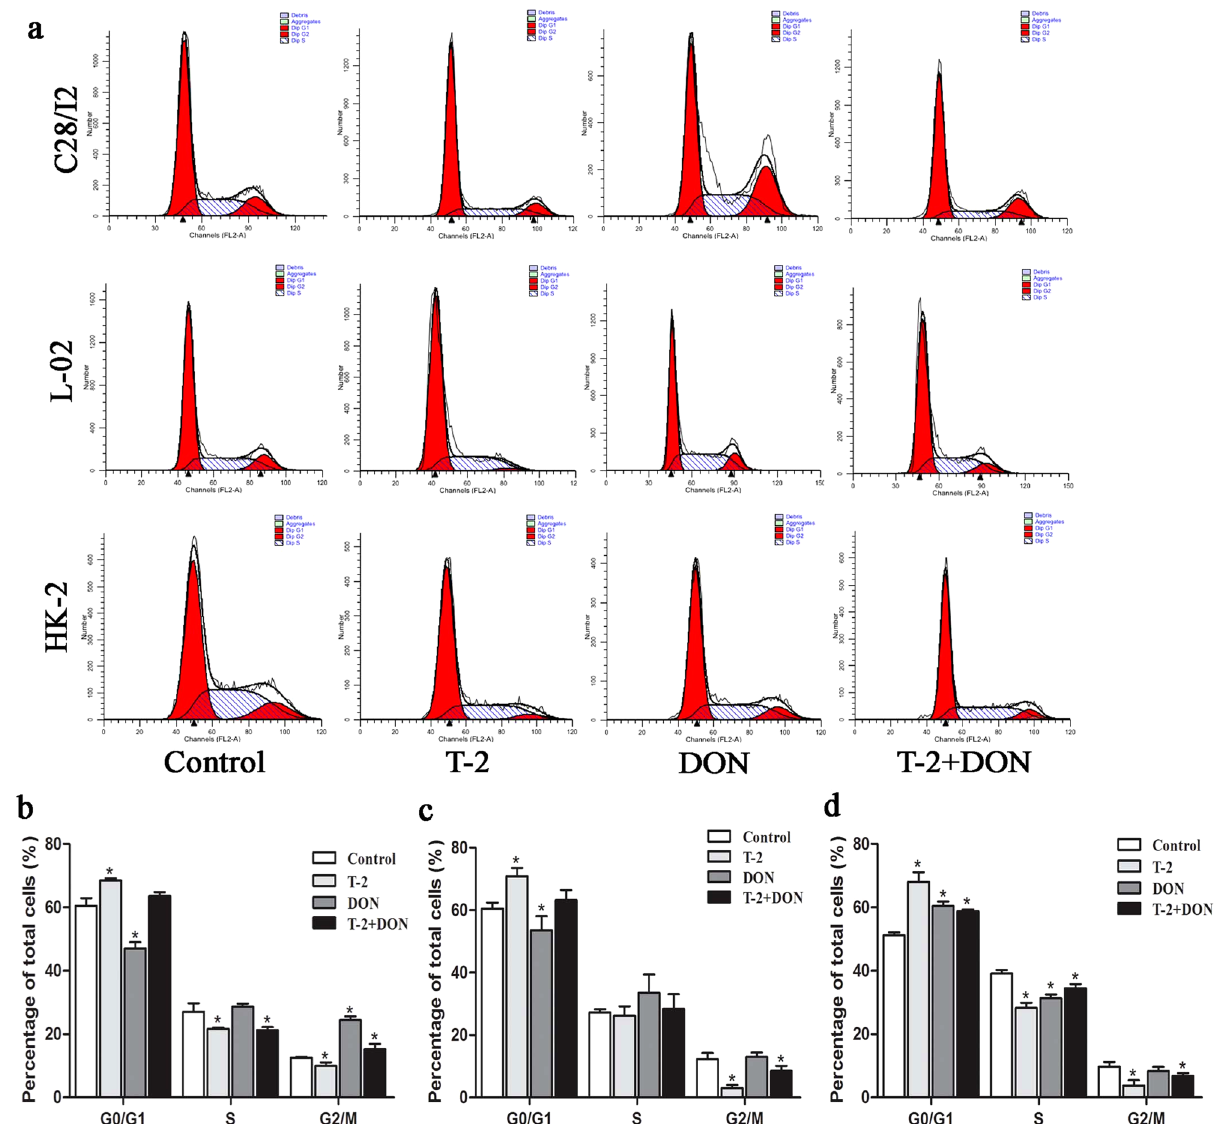
Figure 5. Cell cycle arrest induced by T-2 toxin and/or DON. ( a ) C28/I2, L-02, and HK-2 cells were exposed to T-2 toxin (10 ng/ml) or DON (800 ng/ml), alone or in combination, for 24 h. and cell cycle phase distribution was analyzed by flow cytometry. Cell cycle phase distribution was quantified as the percentage of total cells in C28/I2 ( b ), L-02 ( c ), and HK-2 ( d ) cells. Data are represented as the mean ± SD from three independent experiments; * P < 0.05 indicates significance versus untreated control